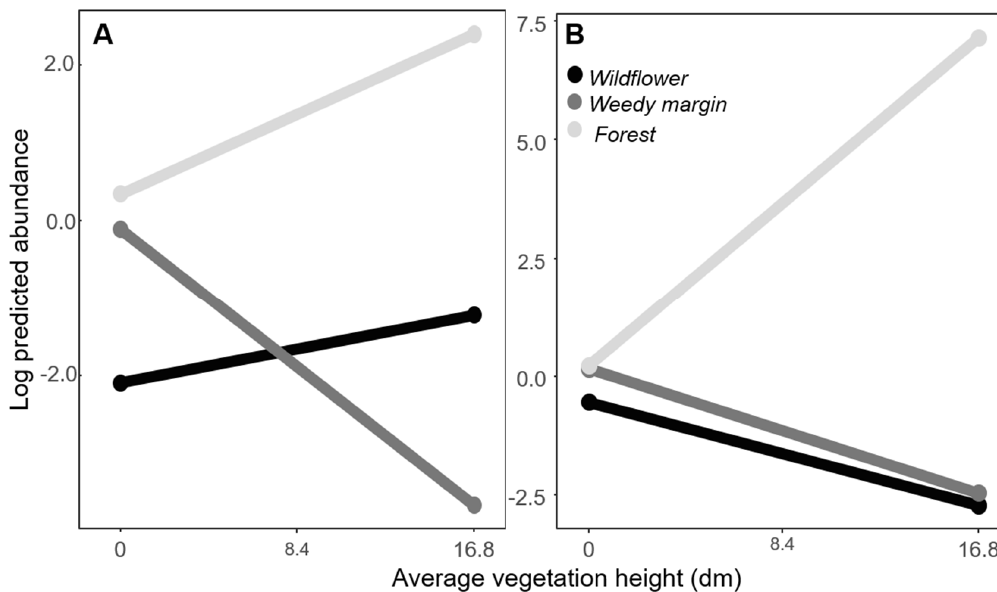
Figure 3. Prediction lines for the abundance of Ambloymma americanum adults ( A ) and nymphs ( B ) by sampling habitat in response to vegetation height.